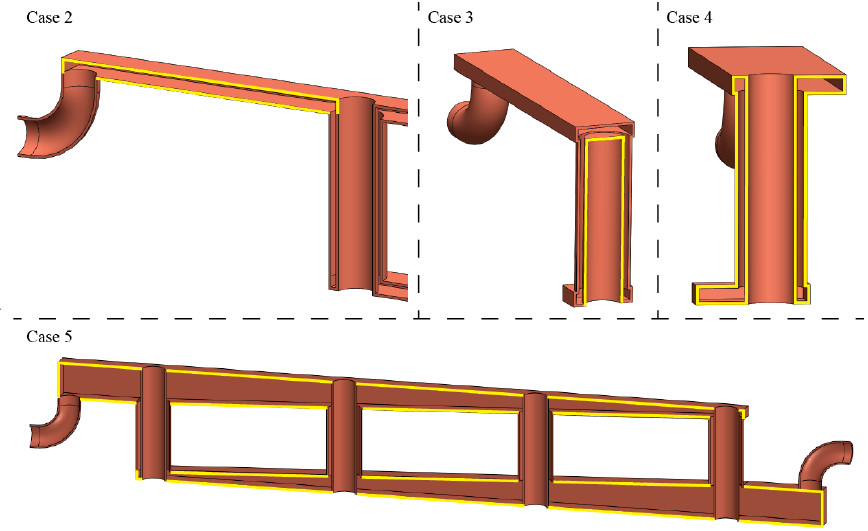
Figure 7. Four basic designs with highlighted major changes from the basic concept.